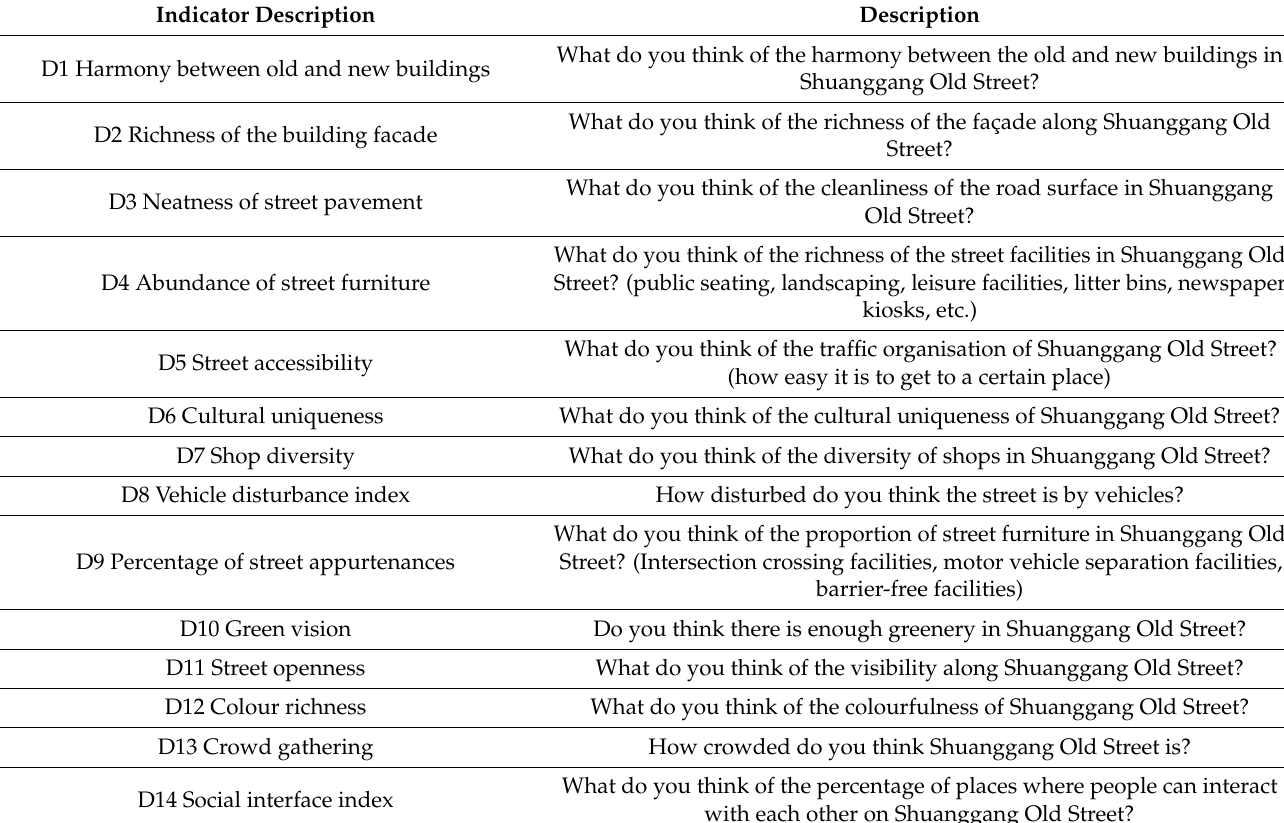
Table 2. Description of the indicator conversion